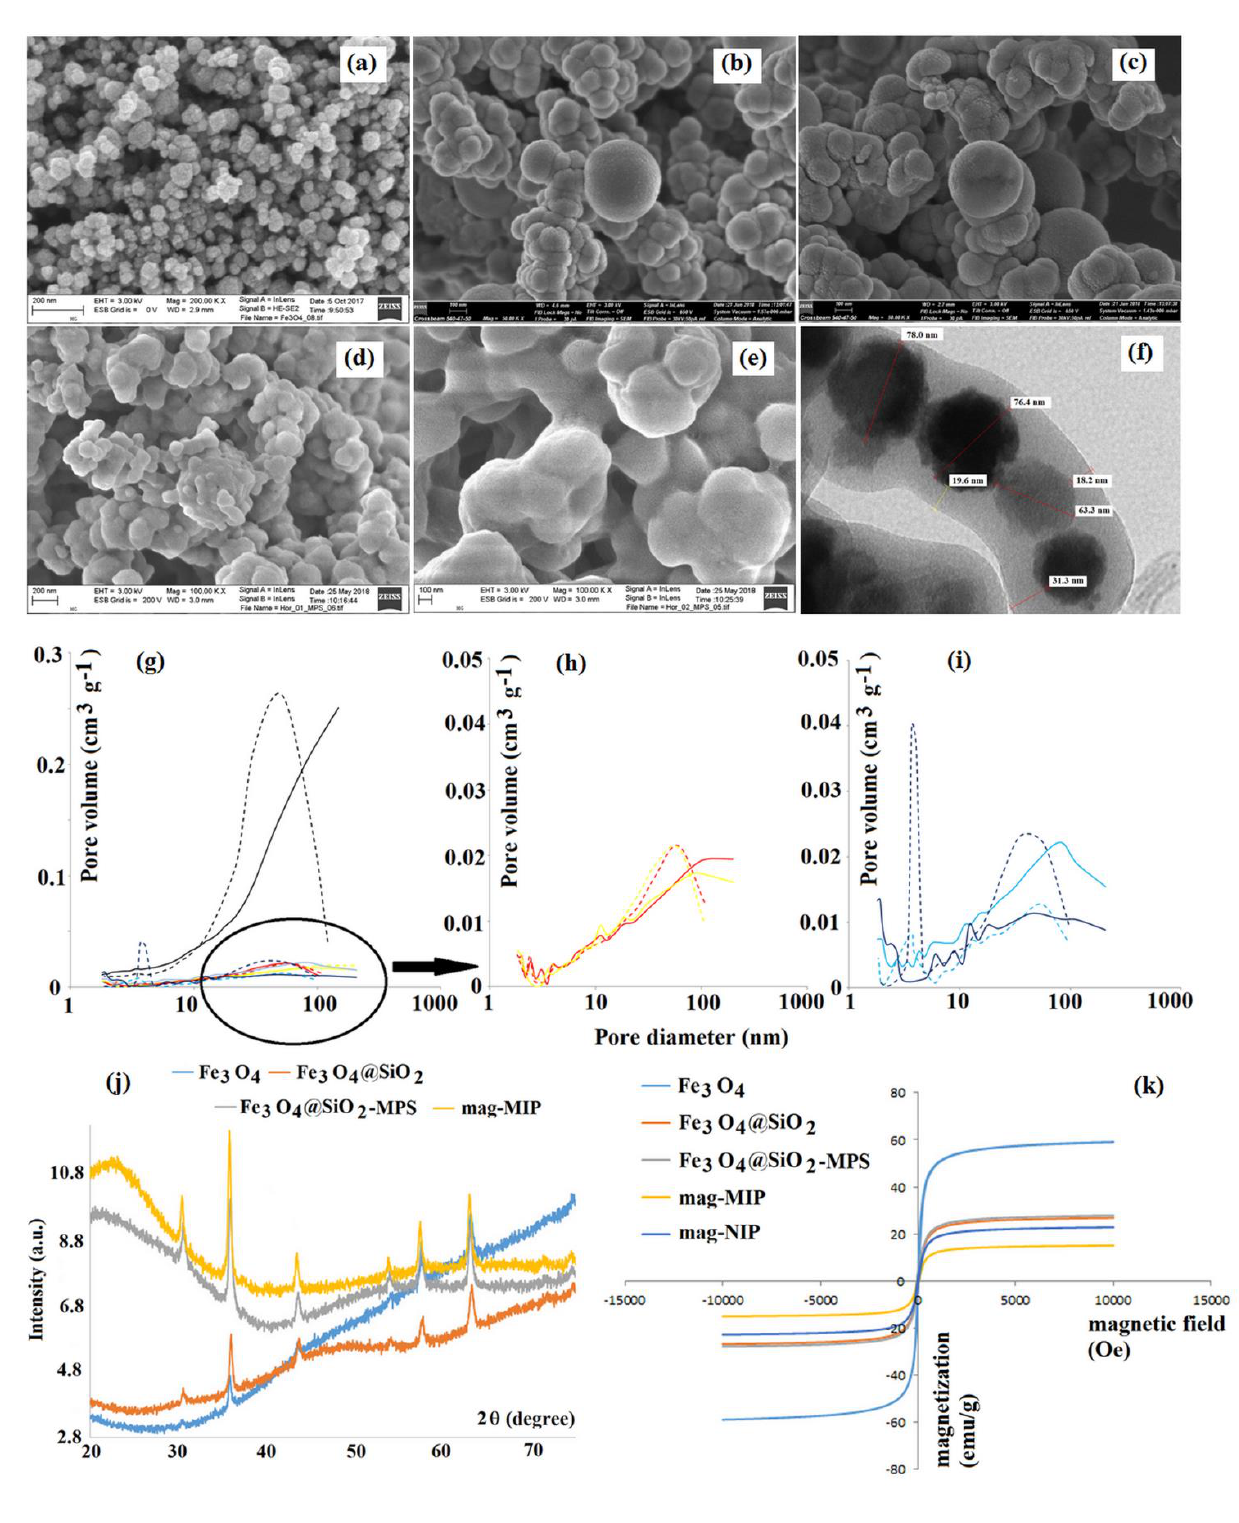
Figure 4. Scanning ( a – e ) and transmission ( f ) electron micrographs, nitrogen sorption data ( g – i ), X-ray diffractogram ( j ), and hysteresis from a vibrating sample magnetometer ( k ) of magnetic imprinted sorbent [84].